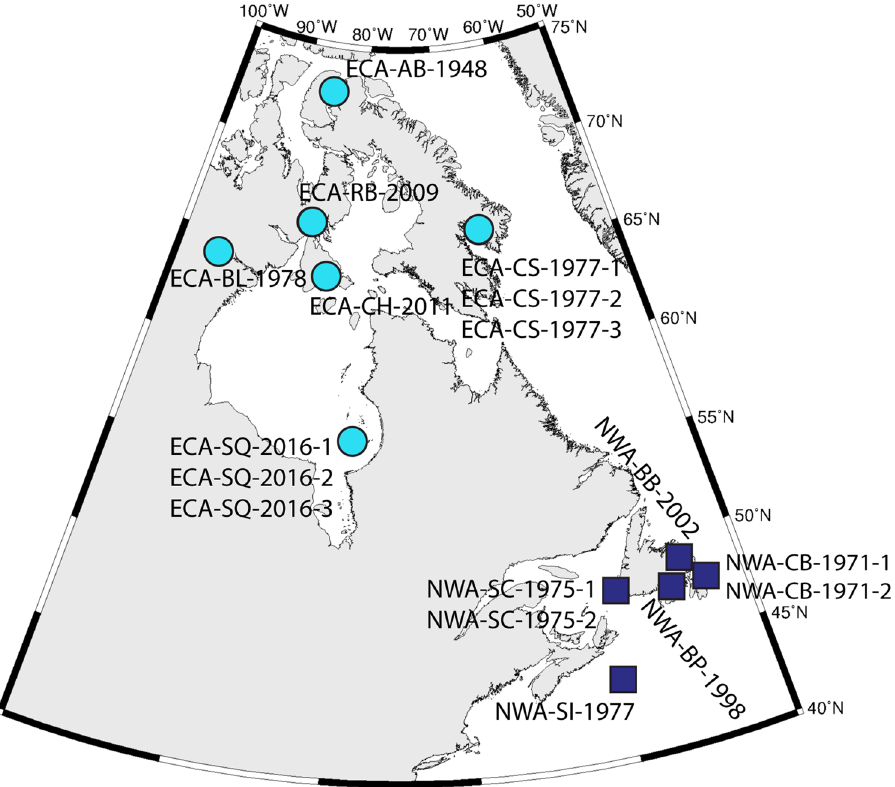
Figure 1. Locations of stranded killer whales in the eastern Canadian Arctic (ECA; turquoise circles) and Northwest Atlantic (NWA; purple squares) included in this study (specimen ID numbers match those presented in Tables 1 and 2). Map was created using the statistical software R (https:// www.r- proje ct. org/) 32